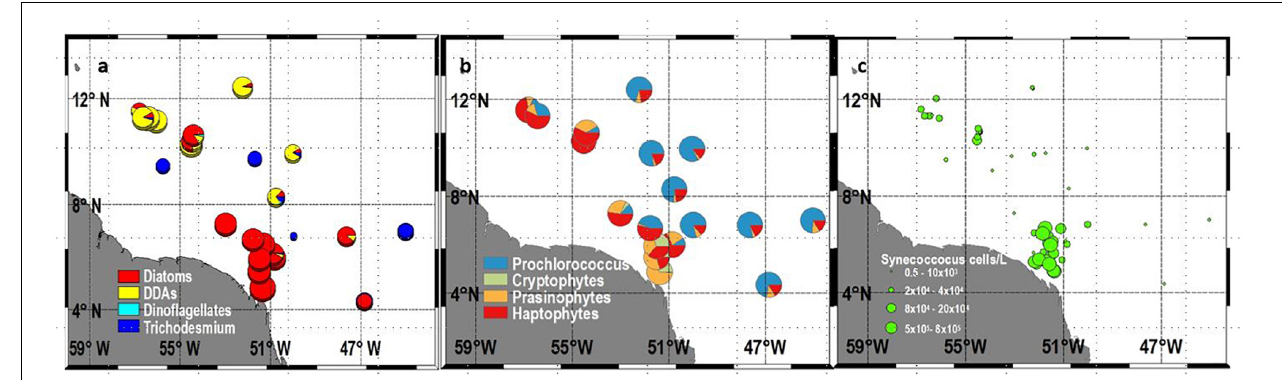
FIGURE 3 | Surface (a) Percent proportion of Microplankton (Diatoms, DDAs, Dinoflagellates, Trichodesmium (b) Percent proportion of Nano and Picoplankton ( Prochlorococcus , Cryptophytes, Prasinophytes, Haptophytes), and (c) Total Synechococcus (cells L − 1